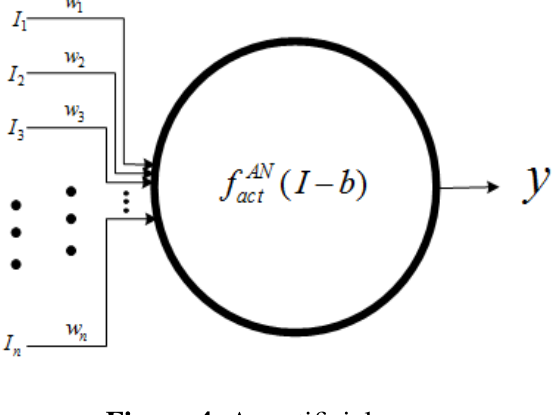
Figure 4. An artificial